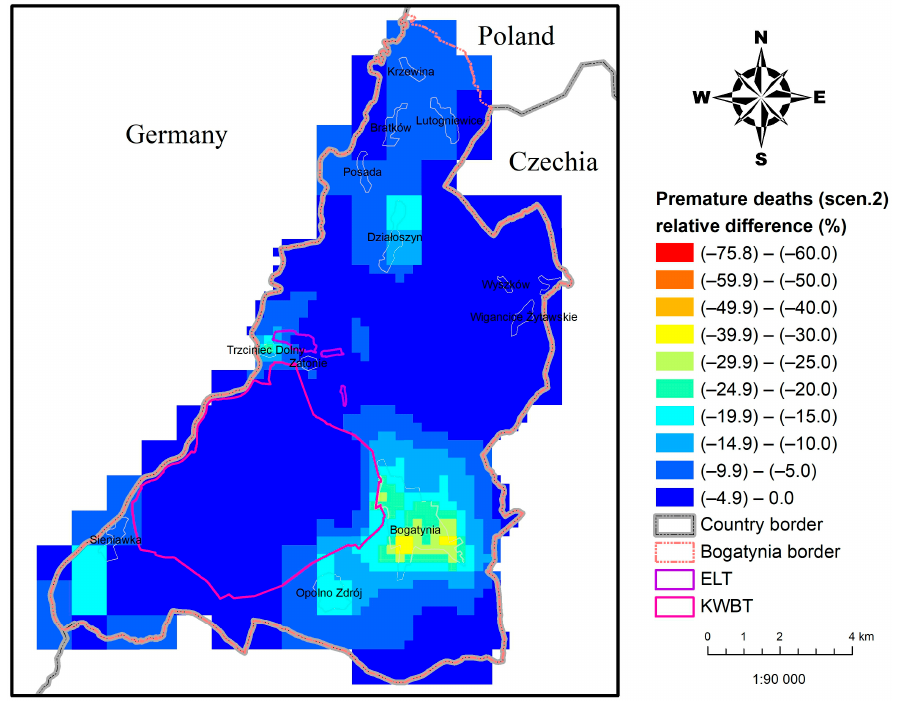
Figure 27. Spatial distribution of relative changes (reductions) in the number of premature deaths for scenario 2 relative to the baseline scenario.